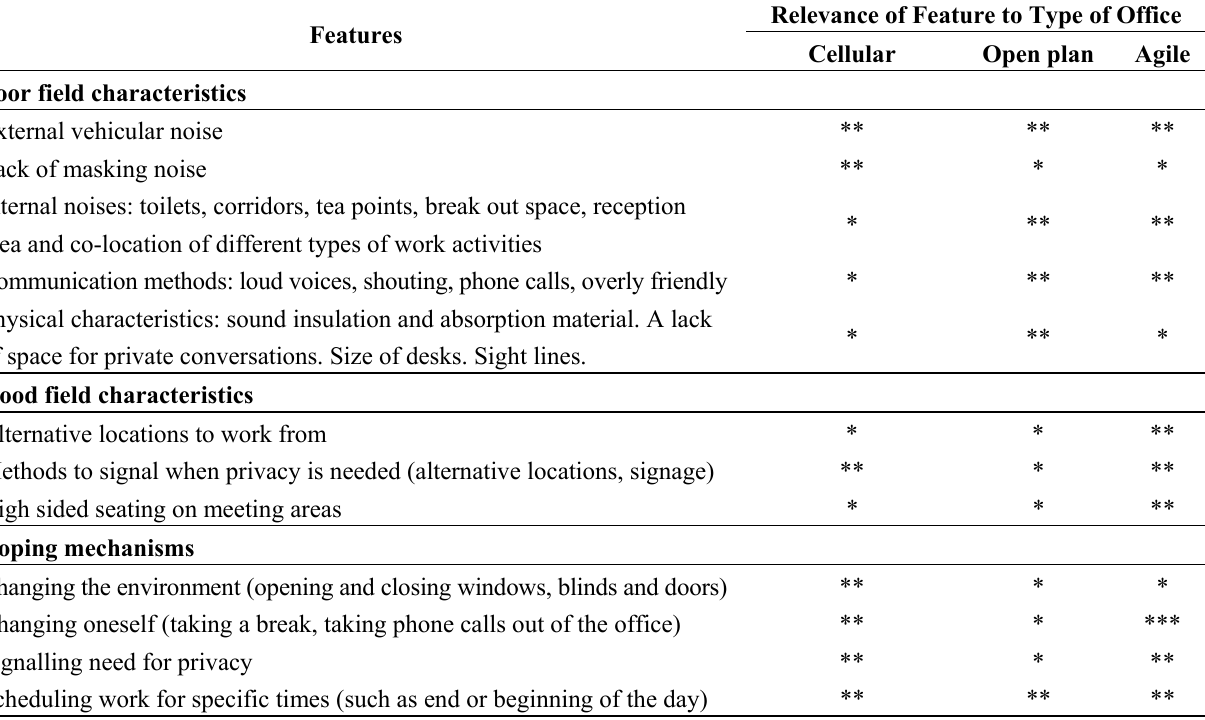
Table 8 . Features that affect the perception of privacy and crowding and their relevance to different office